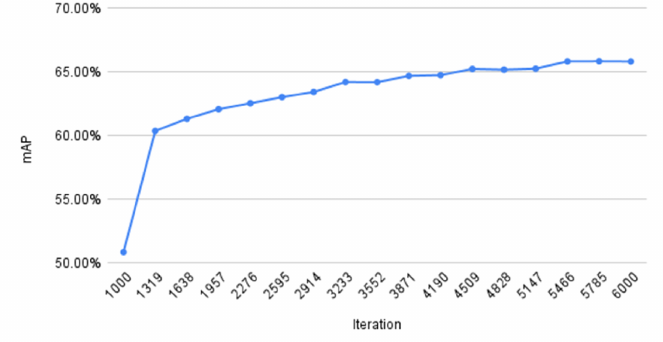
Fig. 3 Average mAP of all eye-glasses-goggles dataset experimental